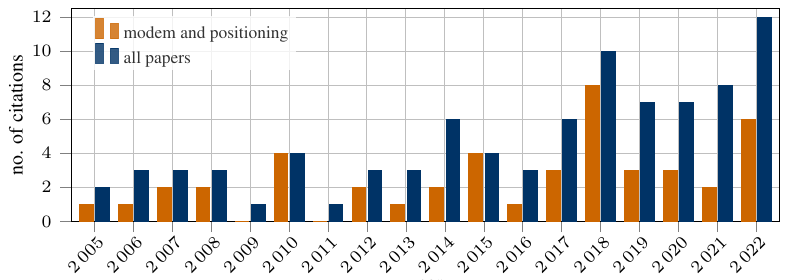
Figure 2. Cited scientific papers compared to the publication date. In sum, 86 scientific papers are discussed in this paper. 45 papers cover acoustic modems and positioning systems and 41 papers examine applications and previous